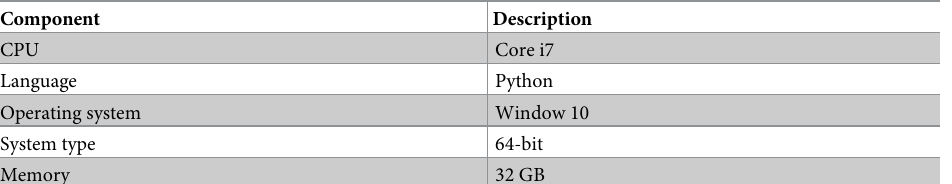
Table 1. System equipment.